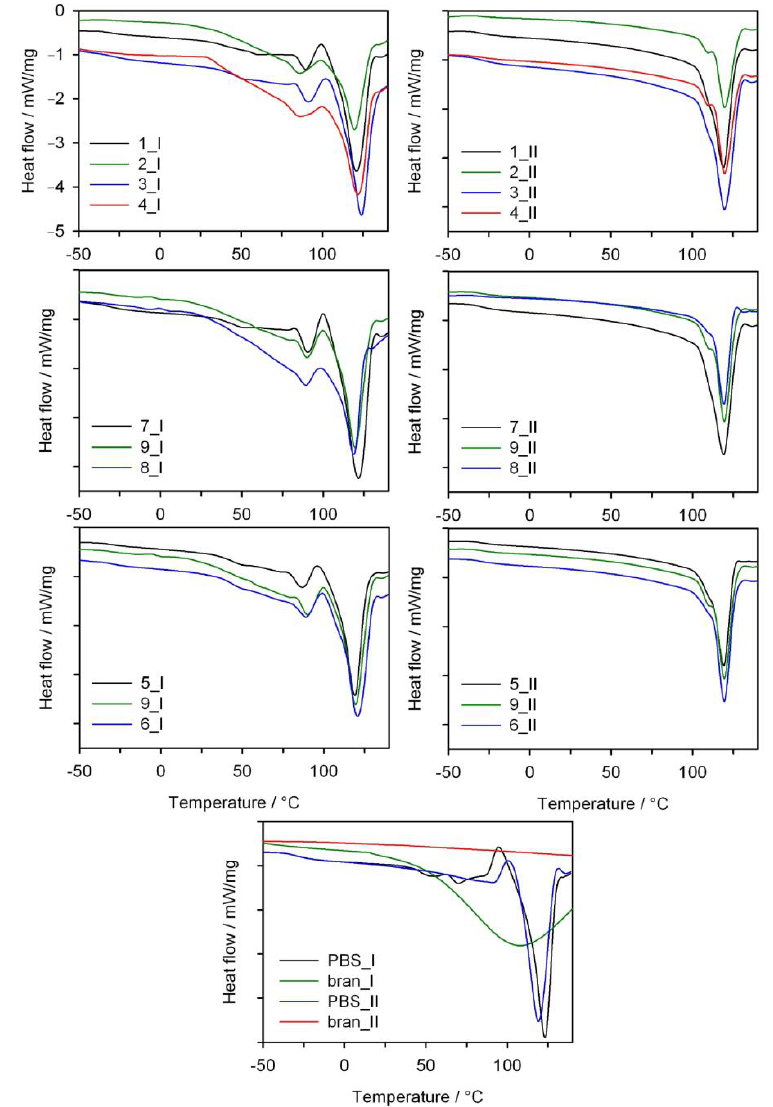
Figure 13. DSC thermograms of the first (I) and second (II) heating scans of neat PBS and its composites with bran (exo up).